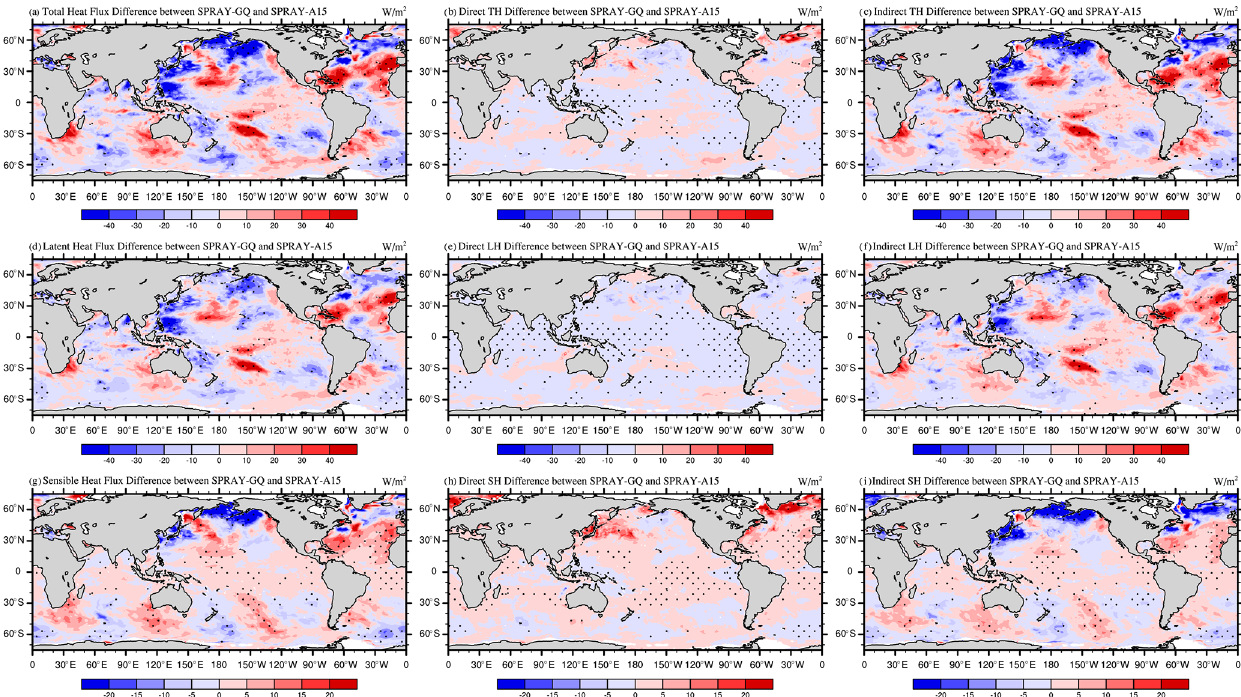
Figure 7. The 53d average differences of total heat flux (a–c) , latent heat flux (d–f) , and sensible heat flux (g–i) between SPRAY-GQ and SPRAY-A15 (SPRAY-GQ minus SPRAY-A15) in January–February 2017. The direct differences indicate sea-spray-mediated heat flux differences (b, e, h) , and the indirect differences indicate interfacial (bulk) heat flux differences resulting from sea spray (c, f, i) . The dotted areas are statistically significant at 95% confidence level. A positive value of flux indicates an upward